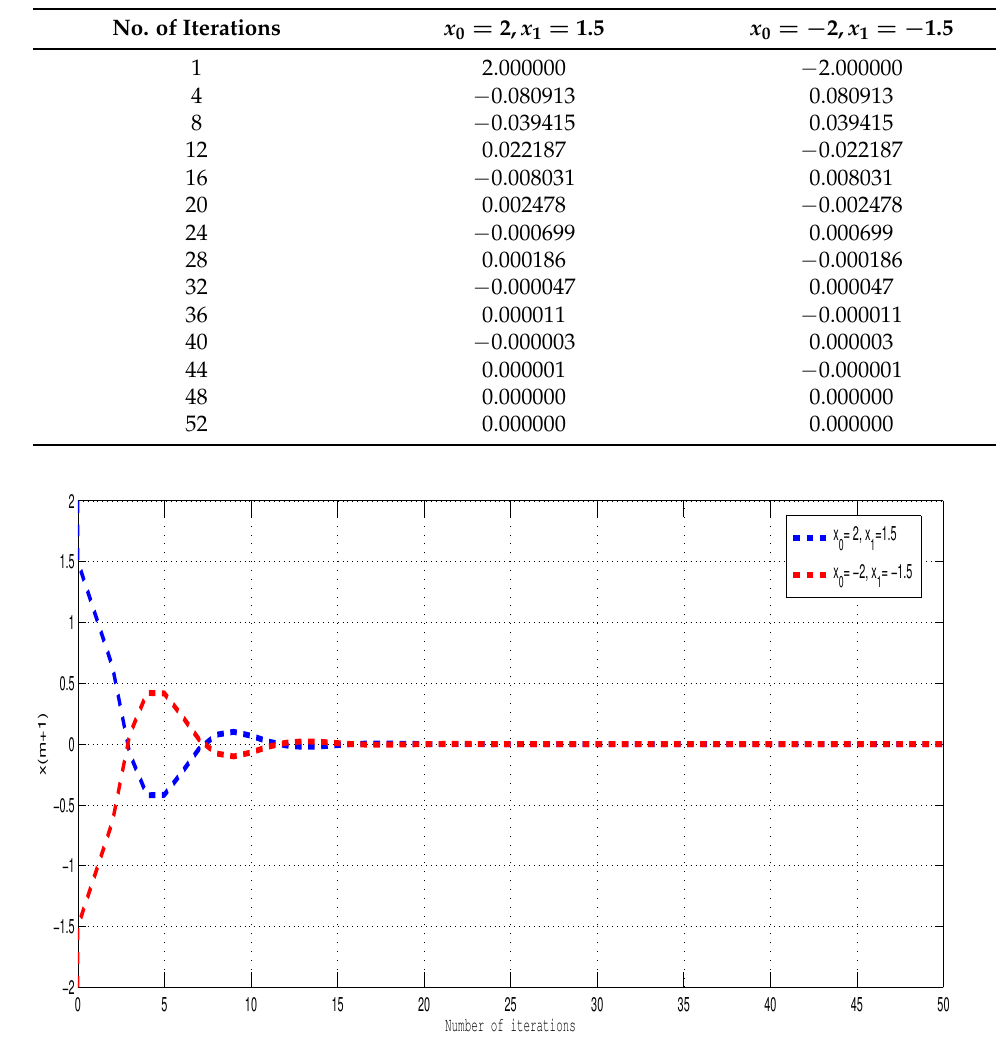
Figure 1. Convergence of sequence { x m }